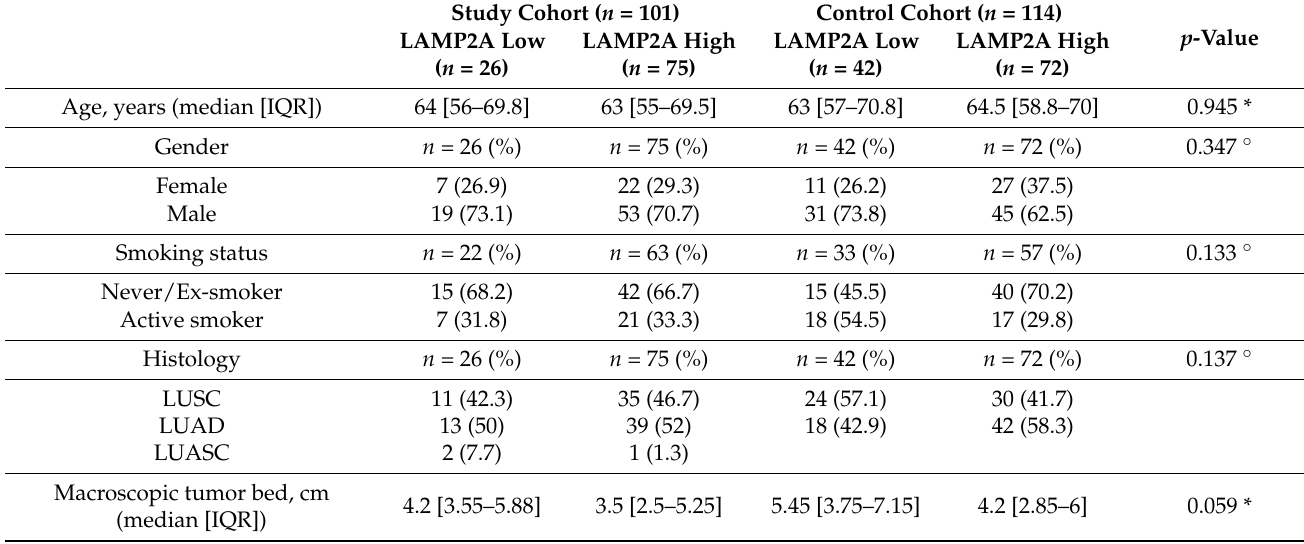
Table 1. Basic clinicopathological characteristics of the study and the control cohort in relation to LAMP2A expression. ◦ Mantel–Haenszel test, * logistic regression, + Wilcoxon rank-sum